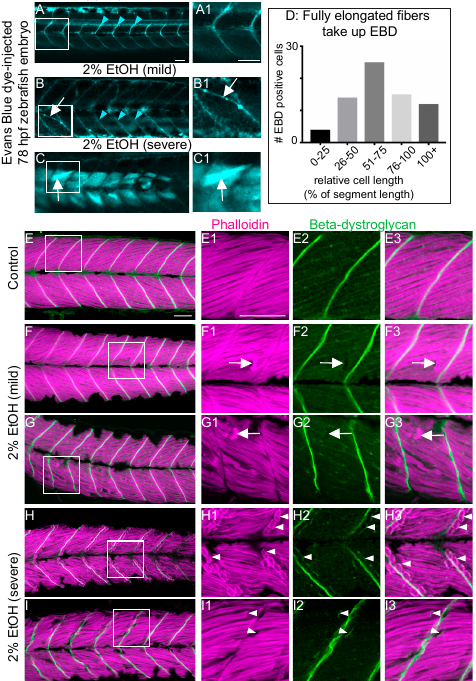
Figure 4. EtOH-induced fiber detachments result from sarcolemmal instability and failure of muscle end attachments. ( A – C1 ) Anterior left, dorsal top, side-mounted, live, 78 hpf embryos treated continuously with 2% EtOH from 30 to 72 hpf, injected with 1% Evans Blue Dye (EBD) (pseudocolored blue) at 72 hpf. White boxes in A, B, and C correspond to zoomed-in, numbered panels A1, B1, and C1, respectively. ( A – A1 ) Control embryo. EBD is in the blood stream (blue arrowheads). ( B – B1 ) Embryo with mild fiber detachment phenotype that was induced by continuous treatment of 2% EtOH from 30 to 72 hpf. EBD is in the blood stream (blue arrowheads). EBD permeates some long muscle fibers (white arrows in B and B1). ( C – C1 ) Embryo with severe fiber detachment phenotype that was induced by continuous treatment of 2% EtOH from 30 to 72 hpf. EBD is in the blood stream (blue arrowheads). EBD permeates long (white arrows in C and C1) and short muscle fibers. ( D ) Quantification of the relative length of EBD-penetrated myofibers. EBD penetrated myofibers ranging from short, retracted fibers to fully elongated, diagonally arrayed, fast-twitch myofibers in EtOH-treated embryos. ( E – I3 ) Anterior left, dorsal top, side-mounted, 72 hpf embryos stained with phalloidin (pseudo-colored fuchsia) to visualize actin and anti-beta-DG antibodies (green). Lettered panels show phalloidin and beta-DG channels merged. White boxes correspond to numbered panels on the right. Panels numbered 1 show zoomed-in images of phalloidin staining only. Panels numbered 2 show zoomed-in images of beta-DG staining only. Panels numbered 3 show zoomed-in images of phalloidin and beta-DG channels merged. ( E – E3 ) Control embryo. Fibers remained long and beta-DG is localized to the MTJ. ( F – G3 ) Embryos treated continuously with 2% EtOH from 30 to 72 hpf showing mild fiber detachment. White arrowheads in F1–F3 and G1–G3 point to retracted fibers unaccompanied by beta-DG. ( H – I3 ) Embryos treated continuously with 2% EtOH from 30 to 72 hpf with severe fiber detachment. White arrowheads in H1–H3 and I1–I3 point to retracted fibers that retained beta-DG at their detached ends. Scale bar is 50 micrometers.